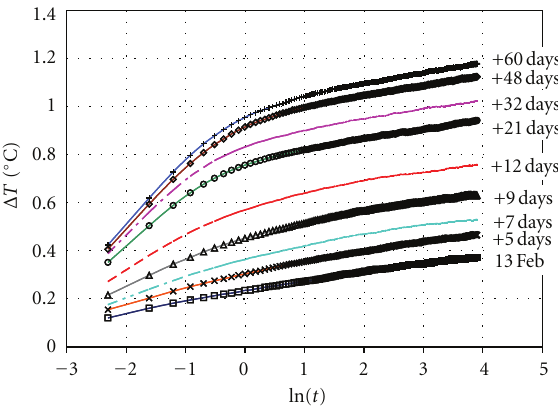
Figure 8: SEM microphotography of the earth brick microstruc- ture. The sand grain is isolated inside the compacted clay matrix. The clay matrix appears very compact and homogeneous. The microcracks are consequence of the sampling of the milimetric block from the brick.